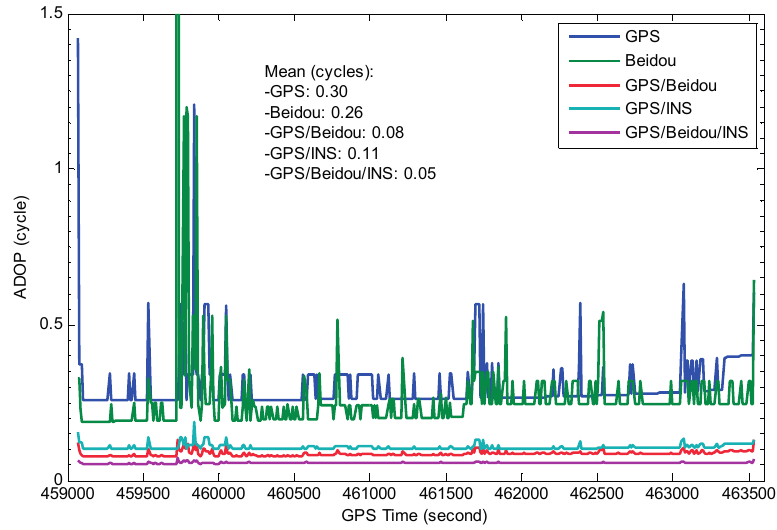
Figure 7. Impact of system configuration on ADOP (INS position STD 0.1 m, 15° cut-off